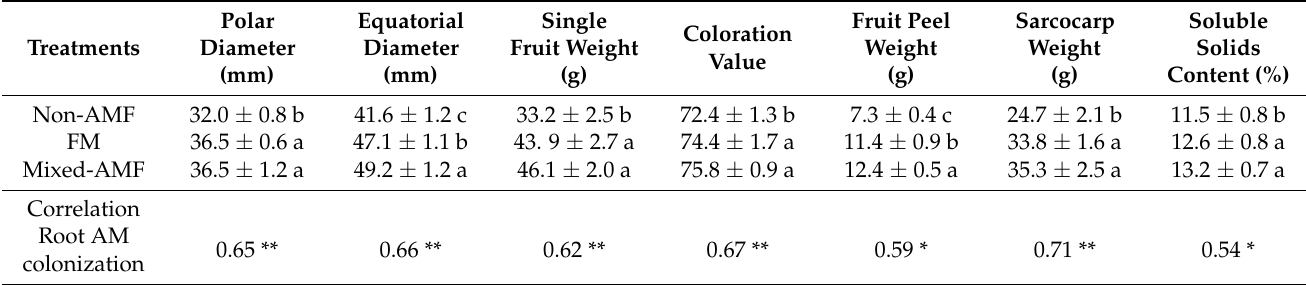
Table 1. Effects of AMF inoculation on internal and external quality of fruits and Pearson’s correlations between root AM colonization and fruit quality.